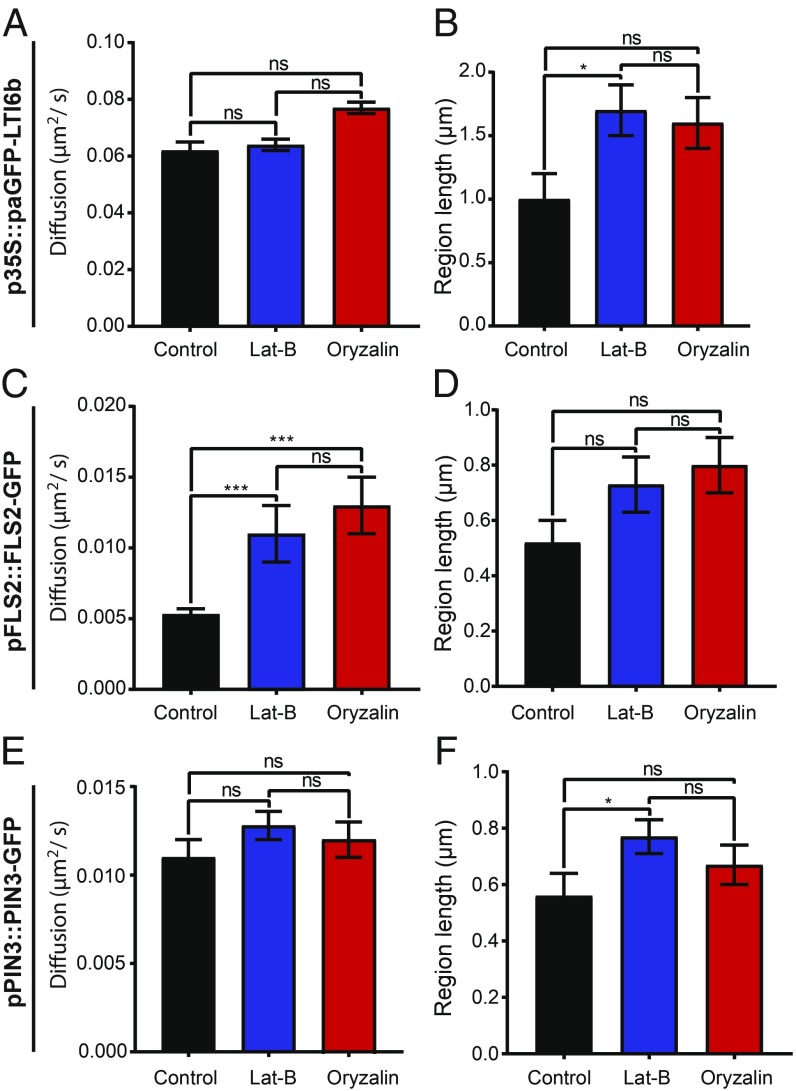
Actin cytoskeleton regulates the mobility of FLS2-GFP in the membrane. Plots show constrained diffusion rate (A, C, and E) and constrained region length (B, D, and F) of single particles within the PM of hypocotyl epidermal cells in controls and after treatment with latrunculin-B (1 h, 25 µM LatB) and oryzalin (1 h, 10 µM) to depolymerize the actin and microtubule cytoskeletons, respectively. (A and B) p35S::paGFP-LTI6b, (C and D) pFLS2::FLS2-GFP, and (E and F) pPIN3::PIN3-GFP. FLS2-GFP becomes significantly more dynamic when either cytoskeleton is depolymerized. *P < 0.05, ***P < 0.01; ns, not significant.